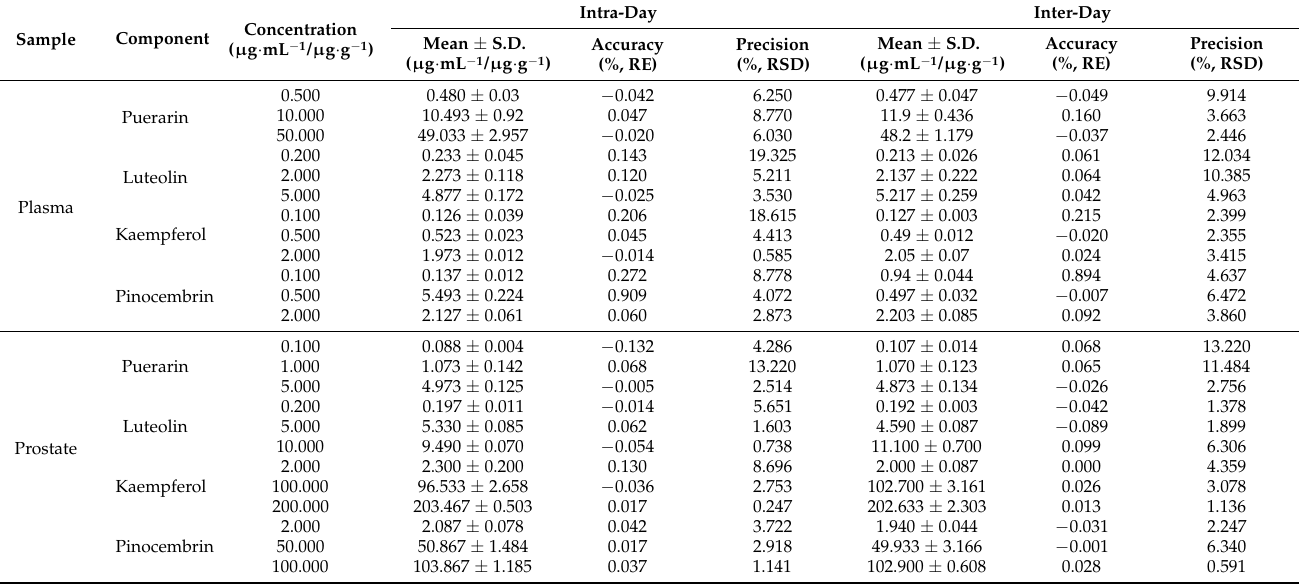
Table 5. Intra-day, inter-day precision and accuracy of the four analytes in plasma and prostate ( n = 3).